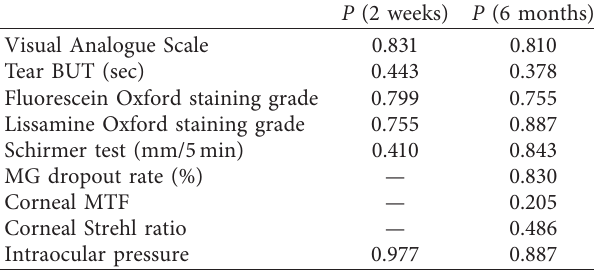
Table 4: P values of differences in study parameters between the two treatment regimens after 2weeks and 6months of